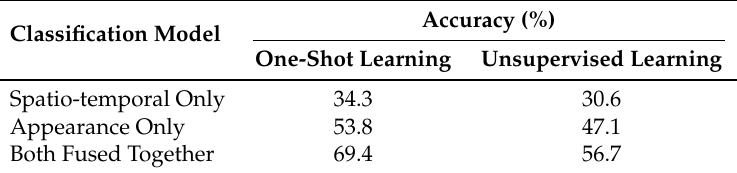
Table 2. System Accuracy with ACF for Person Detection.